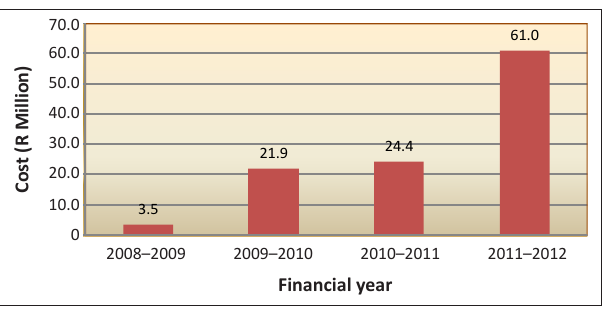
FIGURE 1: Number of year on year incidents.